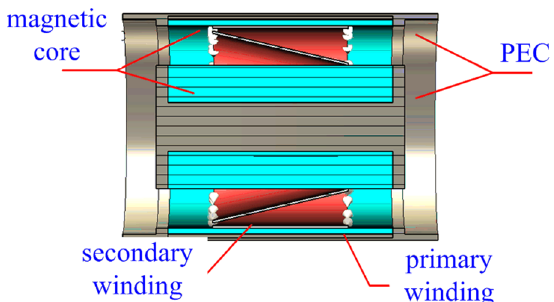
FIG. 7. Schematics of the test experiment on the pulse transformer.FIG. 6. Model in the finite elemental magnetostatic-field simu-